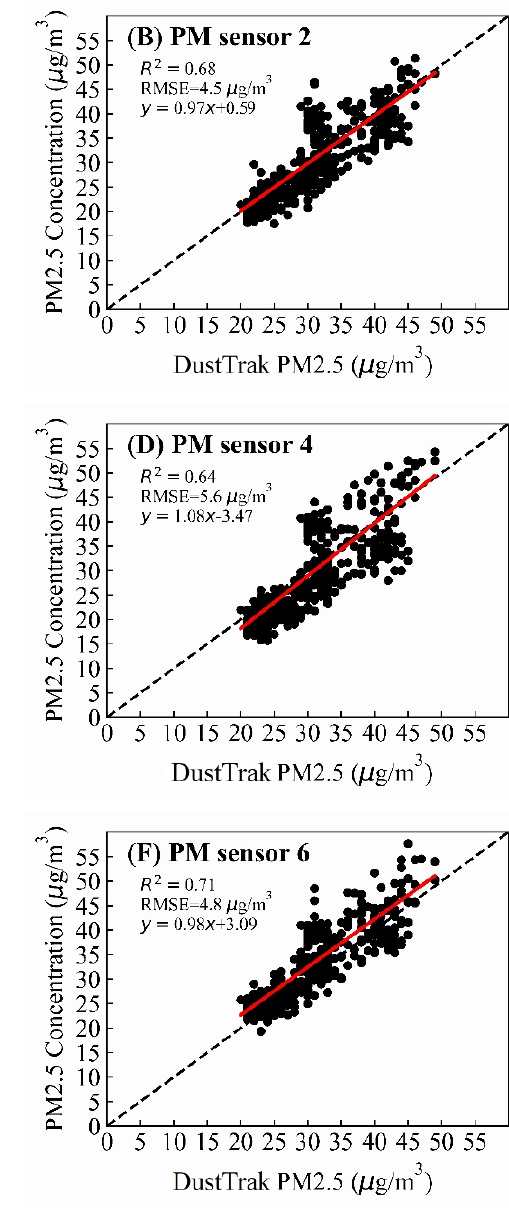
Figure 2. Comparisons of PM 2.5 concentration measured by sensors 1–6 and DustTrak. (Relationship between DustTrak PM 2.5 concentration and PM 2.5 concentration of PM sensor 1, PM sensor 2, PM sensor 3, PM sensor 4, PM sensor 5, PM sensor 6. The red line is a linear fitting line of DustTrak PM 2.5 concentration and PM 2.5 concentration of PM sensor).